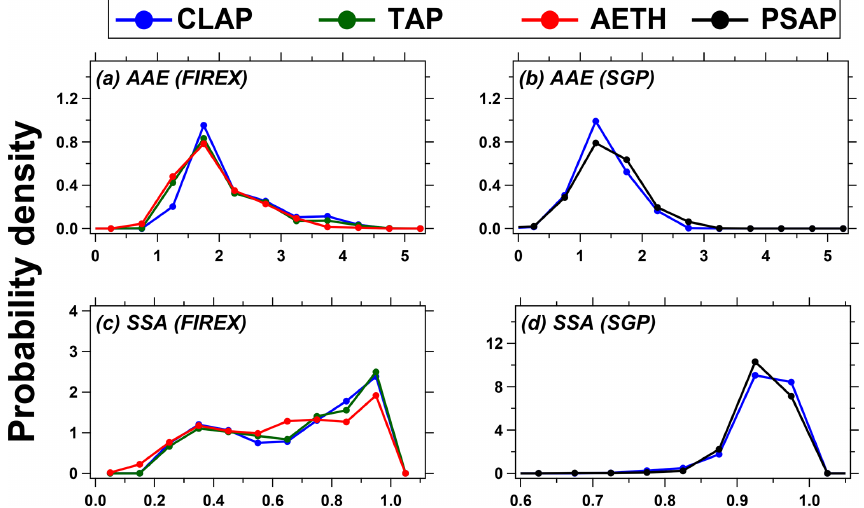
Figure 12. The probability density of AAE and SSA (652nm) derived by different filter-based photometers B abs (corrected by Algorithm A in the present work). Note that the number of total observations varies across